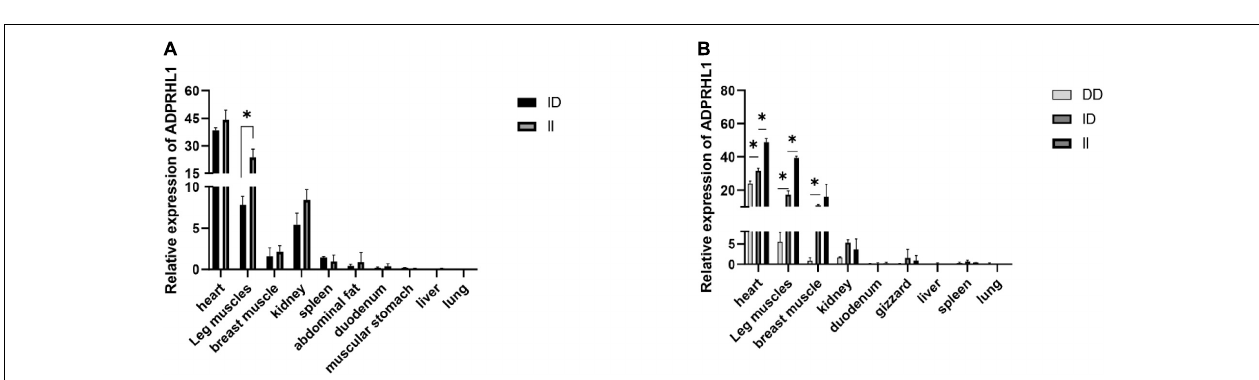
FIGURE 4 | Agarose gel electrophoresis pattern for the ADPRHL1 104-bp indel polymorphism.